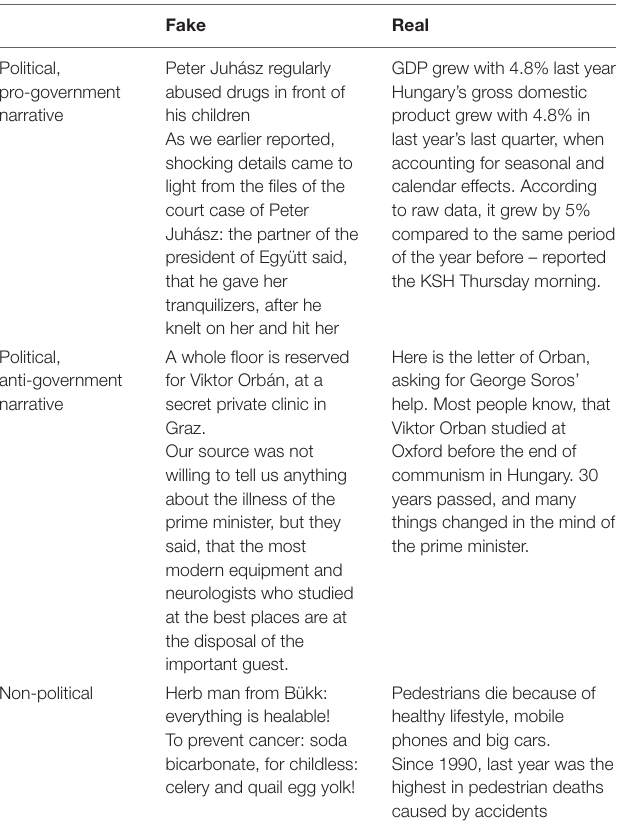
TABLE 1 | Examples of the different news types included in the study, including the headline and